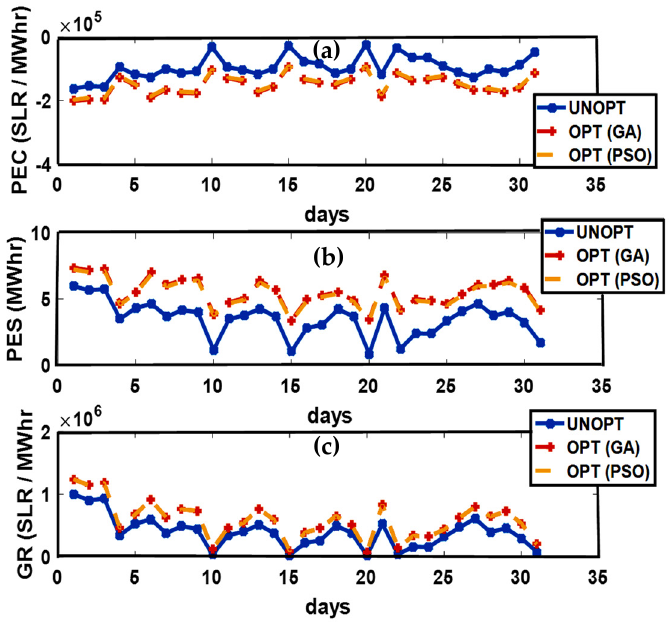
Figure 4. ( a ) Prosumer Energy Cost (PEC), ( b ) Prosumer Energy Surplus (PES), ( c ) Grid Revenue (GR).